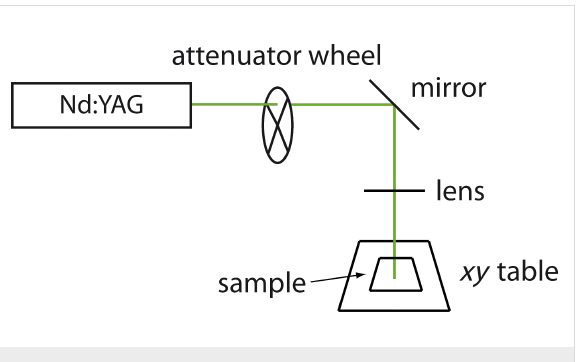
Figure 10: Sketch of the optical setup used for the experiments on the “dry”